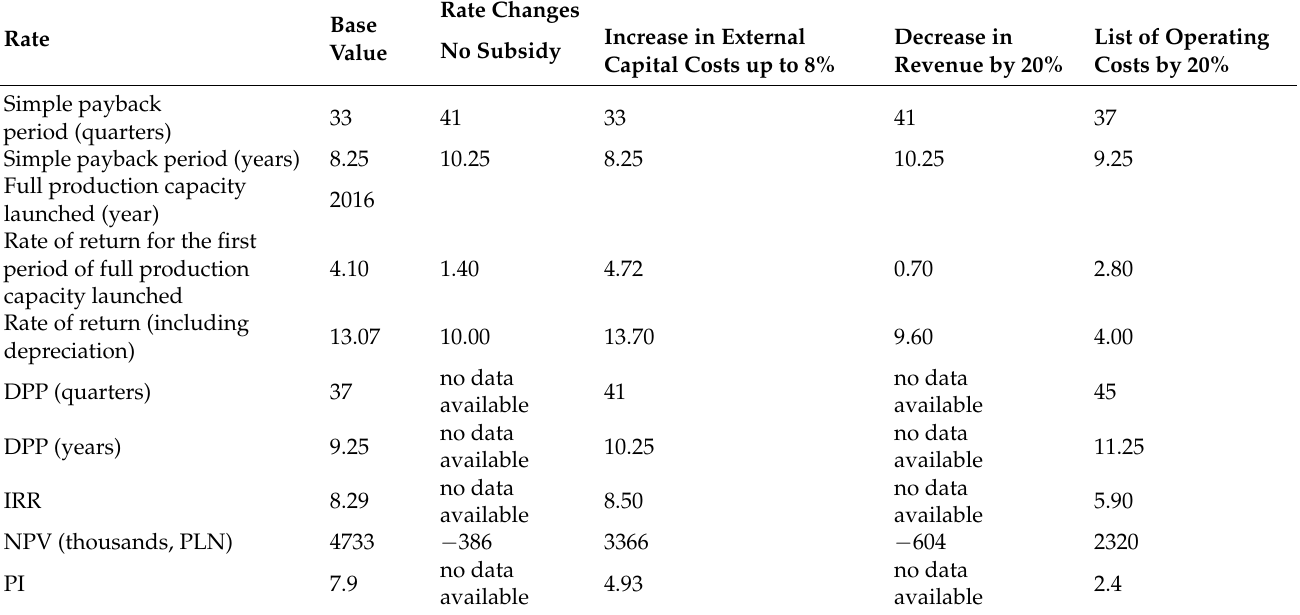
Table 3. Investment profitability